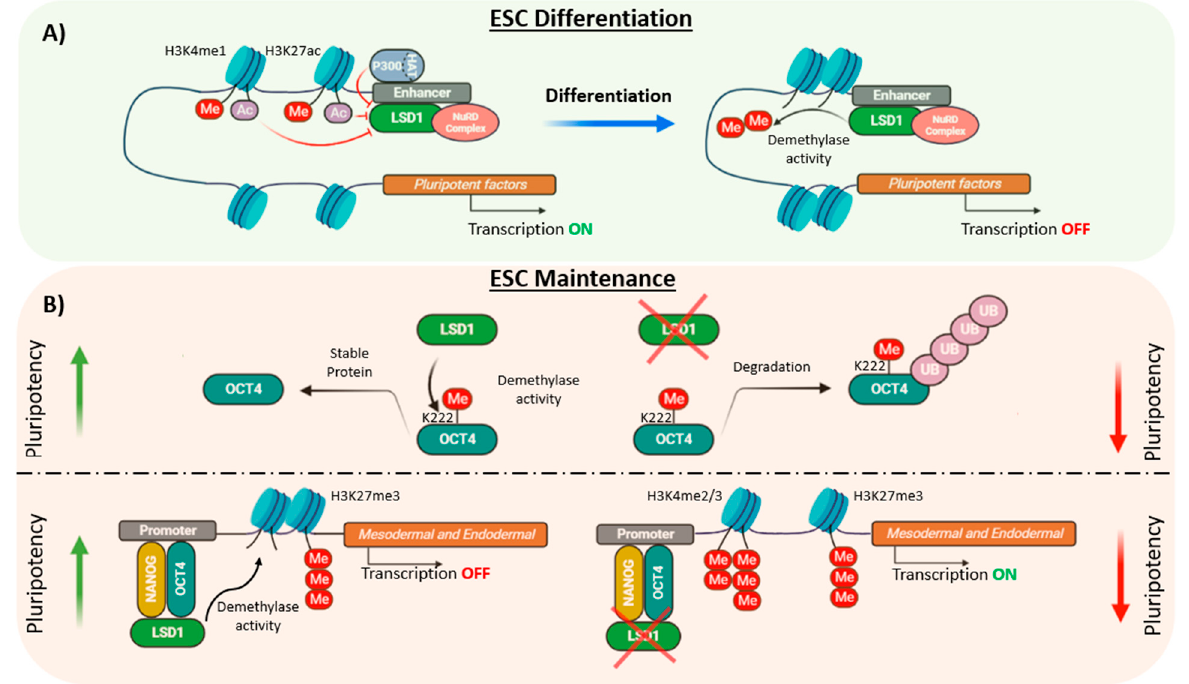
Figure 3. Role of LSD1 in ESC differentiation and maintenance. ( A ) LSD1 is not essential for ESC self-renewal but for differentiation. LSD1 is poised at the enhancers of pluripotent factors where p300/HAT inhibits its activity and therefore, transcription can occur. During differentiation, H3K4me1 LSD1-mediated demethylation switches off the expression of pluripotent factors. ( B ) LSD1 can affect pluripotency levels by demethylating OCT4 at residue K222, which impedes its degradation by the proteasome. In human ESCs, LSD1 occupies, together with OCT4 and NANOG, the promoters of mesodermal and endodermal genes. It demethylates H3K4me2/3 maintaining the silencing of developmental genes.